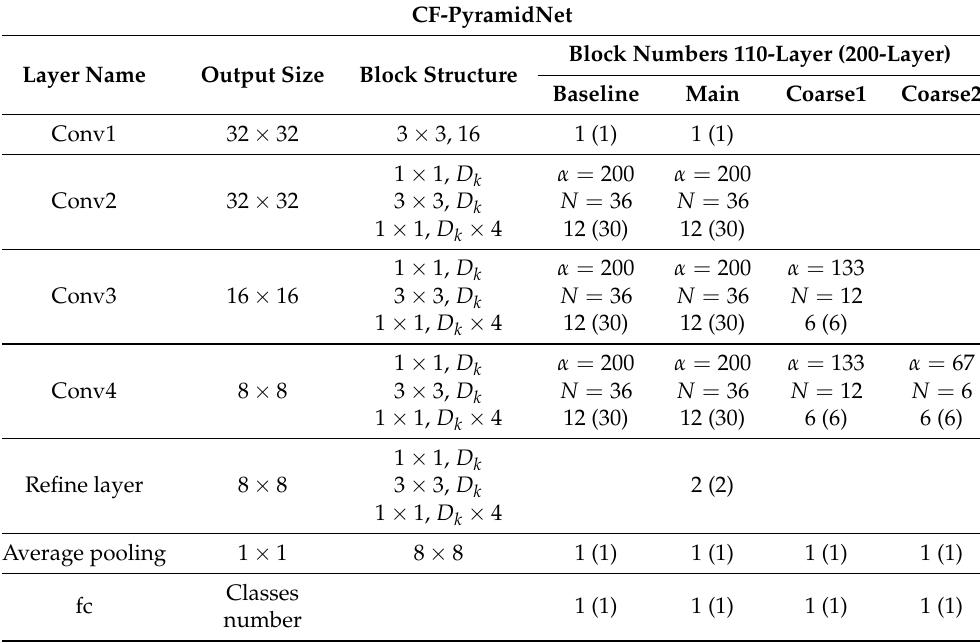
Table 5. Structure of the CF-PyramidNet model for CIFAR-10 and CIFAR-100 datasets.